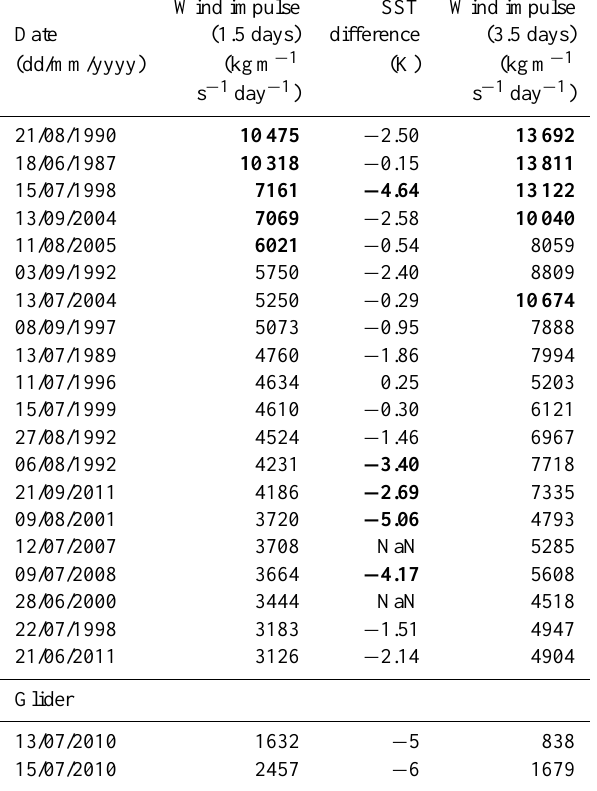
Table 1. Twenty most significant summer (June to September) up- welling events in relation to BE surveys (1982–2012) ordered by wind impulse per day (over a period of 1.5 days before the BE sur- vey). The temperature difference between Kiel lighthouse and the BE survey as well as the wind impulse per day based on the 3.5 days before the BE survey and estimate from Schönhagen wind data are given. The top five events in each category are weighted bold. For reference the intensity as calculated for the glider survey is given at the end of the table.